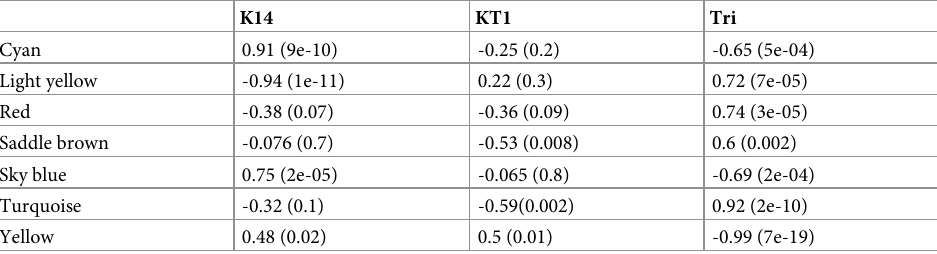
Note: P values are shown in